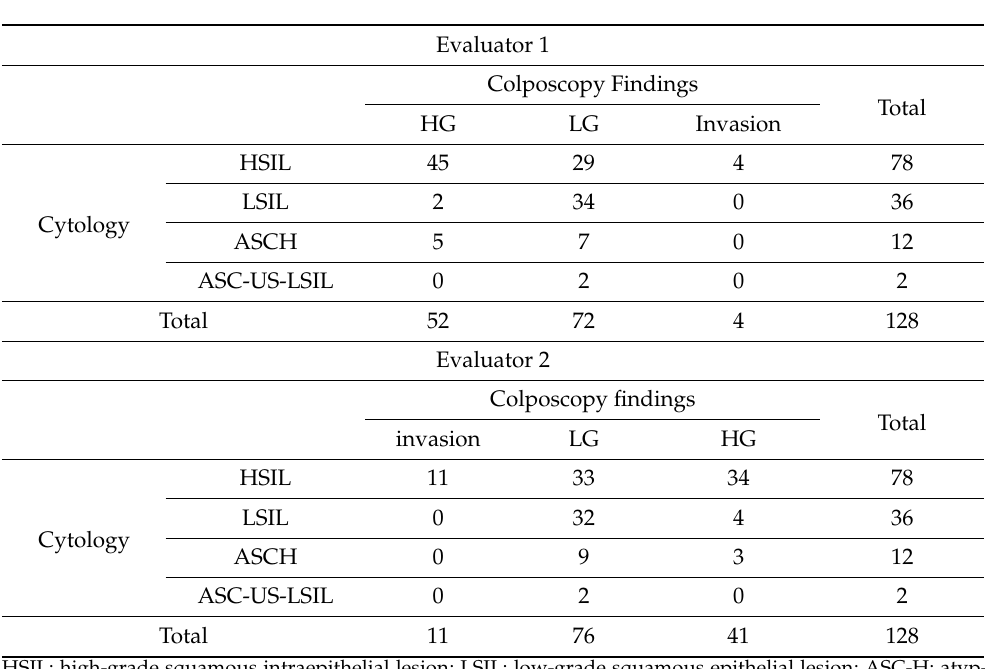
Figure 1. Cervical cytology distribution by patient age. Table 1. Correspondence between colposcopic findings and cytology results obtained by evaluators 1 HSIL was the most frequent cytological result (60.9%) followed by LSIL (28.1%), and ASC-H (9.4%), and ASC-US–repeated LSIL (1.6%). The colposcopic evaluations per-